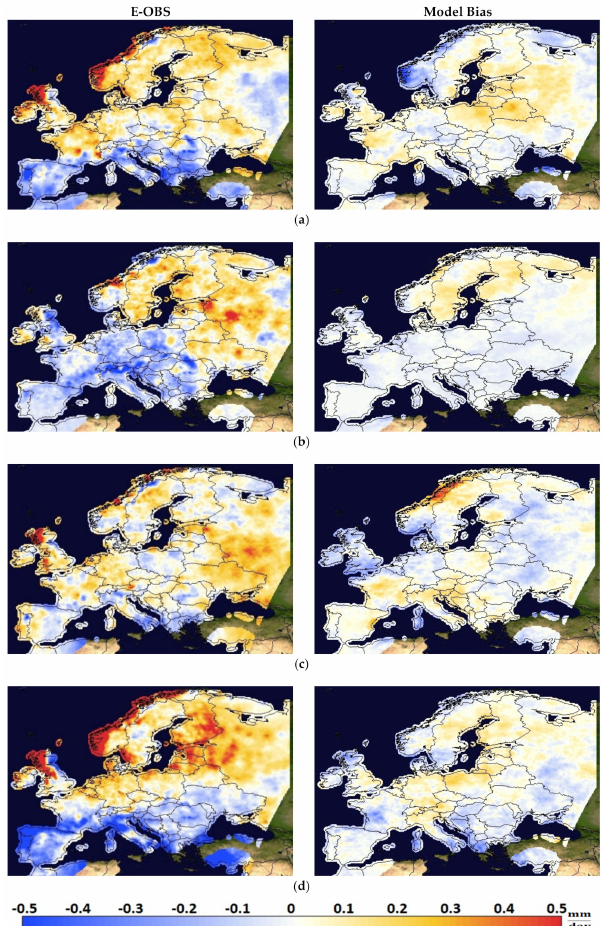
Figure 8. Mean change in the number of days/month with mean precipitation over 5 mm observed (E-OBS, left panels) and the related model biases (E-OBS-model, right panels) between current and historic periods for ( a ) spring (MAM), ( b ) summer (JJA), ( c ) autumn (SON), and ( d ) winter (DJF). As per summer, in every subregion, the number of days with mean daily precipitation of more than 5 mm has declined (Figure 8b, left panel), except for SC, which has seen an increase of 1 day. The most significant shift has occurred in AL, resulting in a total loss of 2 days as compared to the average of the historic summers. The decline is not significant in IP, FR, ME, or MD (all subregions demonstrated a 1-day drop). There was a marginal rise in some areas of BI, but the index did not experience any changes generally. The bias of the model is displayed in the right panel of Figure 8b. Although the bias is characterized by small regional fluctuations, in total, a bias of zero is estimated for all subregions, with a profound trend of slight overestimation everywhere, except for most parts of